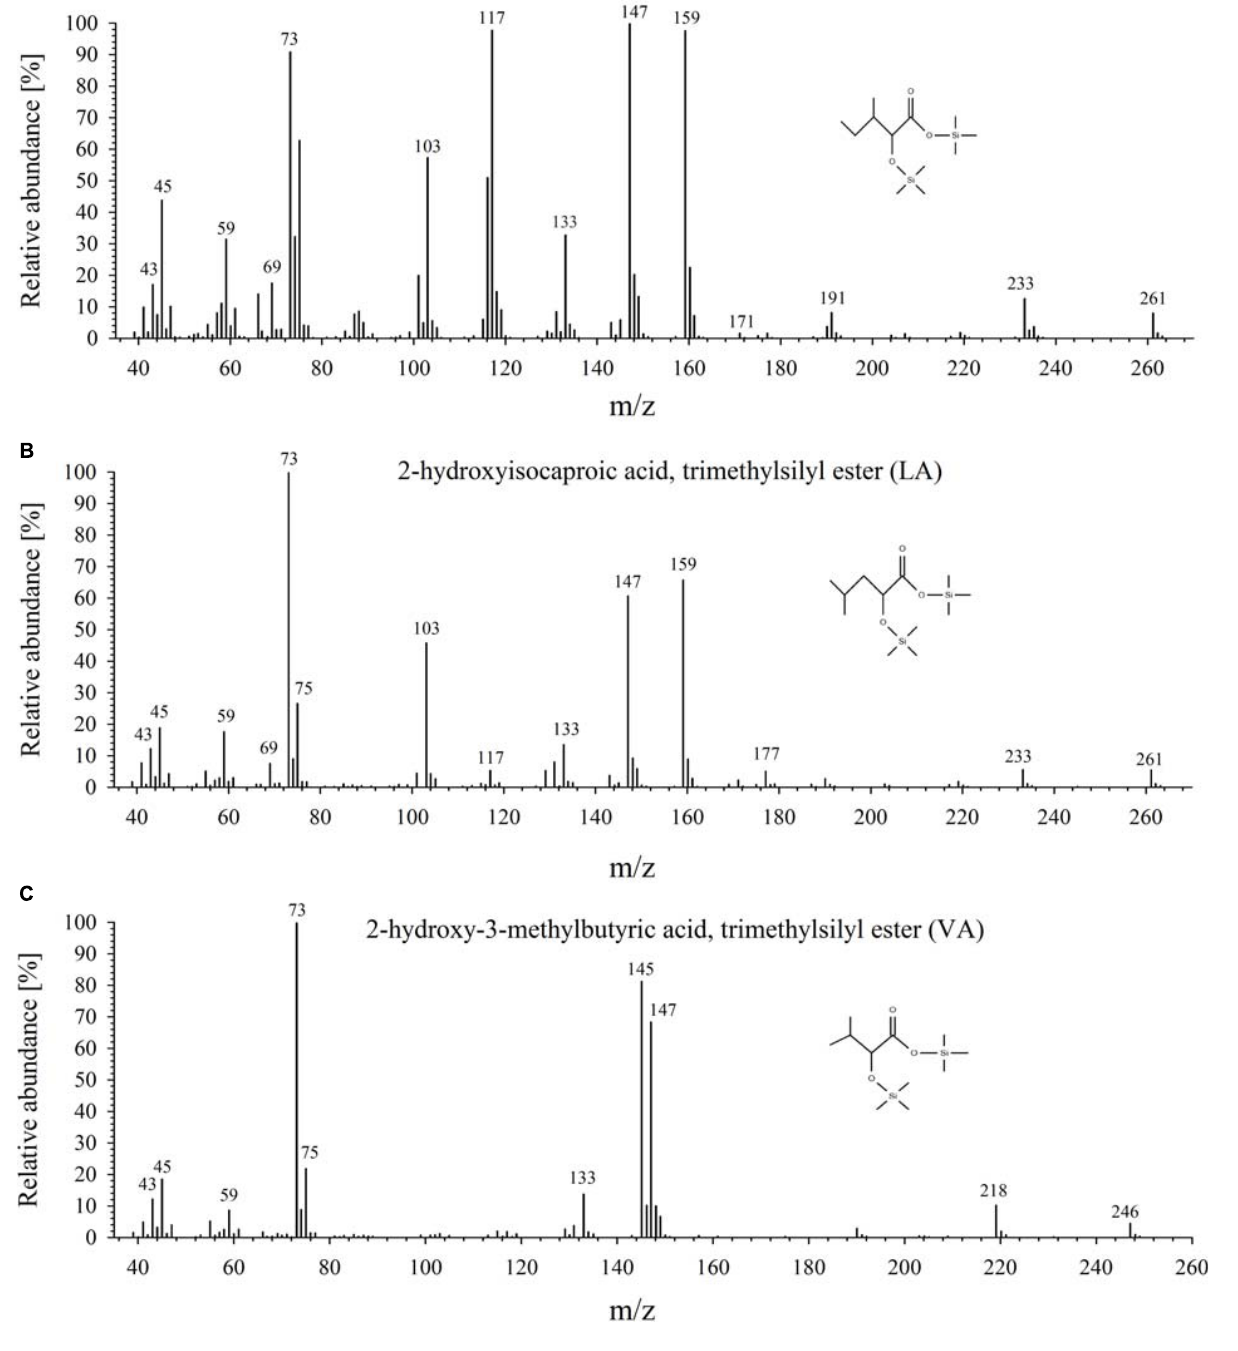
FIGURE 1 | Mass-spectrometric analysis of ILA, LA, and VA. Mass spectra of the trimethylsilyl-derivatized products for (A) ILA, (B) LA, and (C) VA.